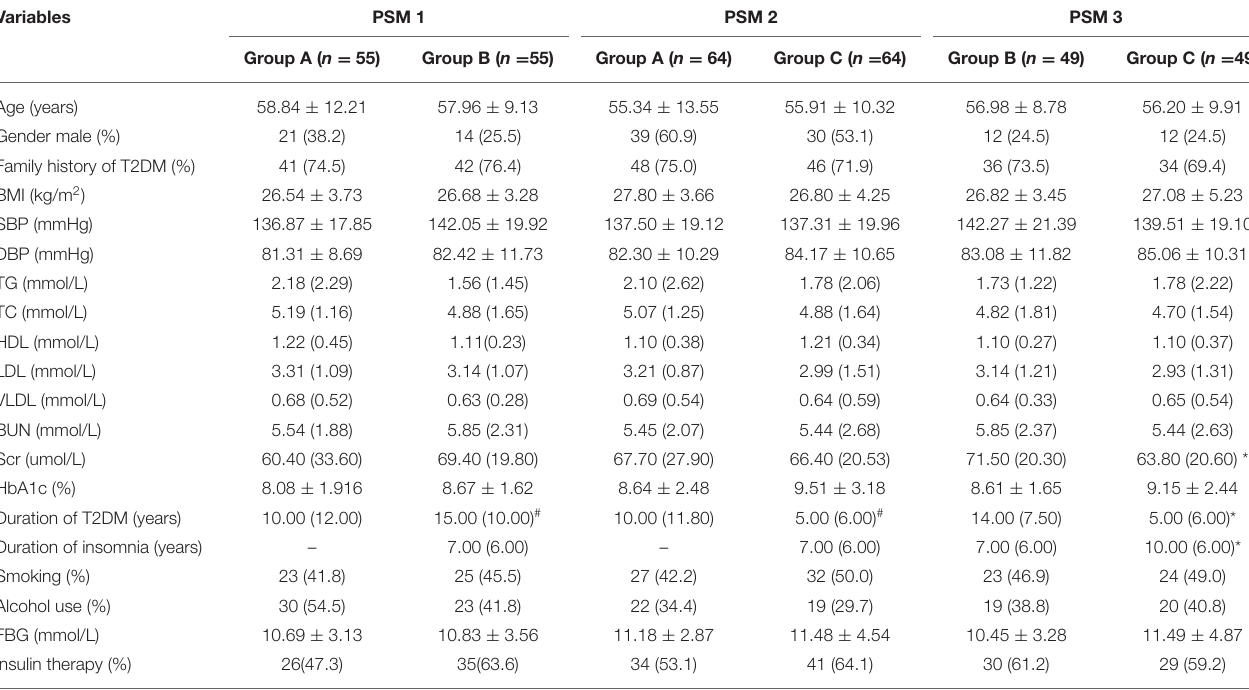
TABLE 2 | Clinical and laboratory characteristics of study participants after propensity score matching. Variables